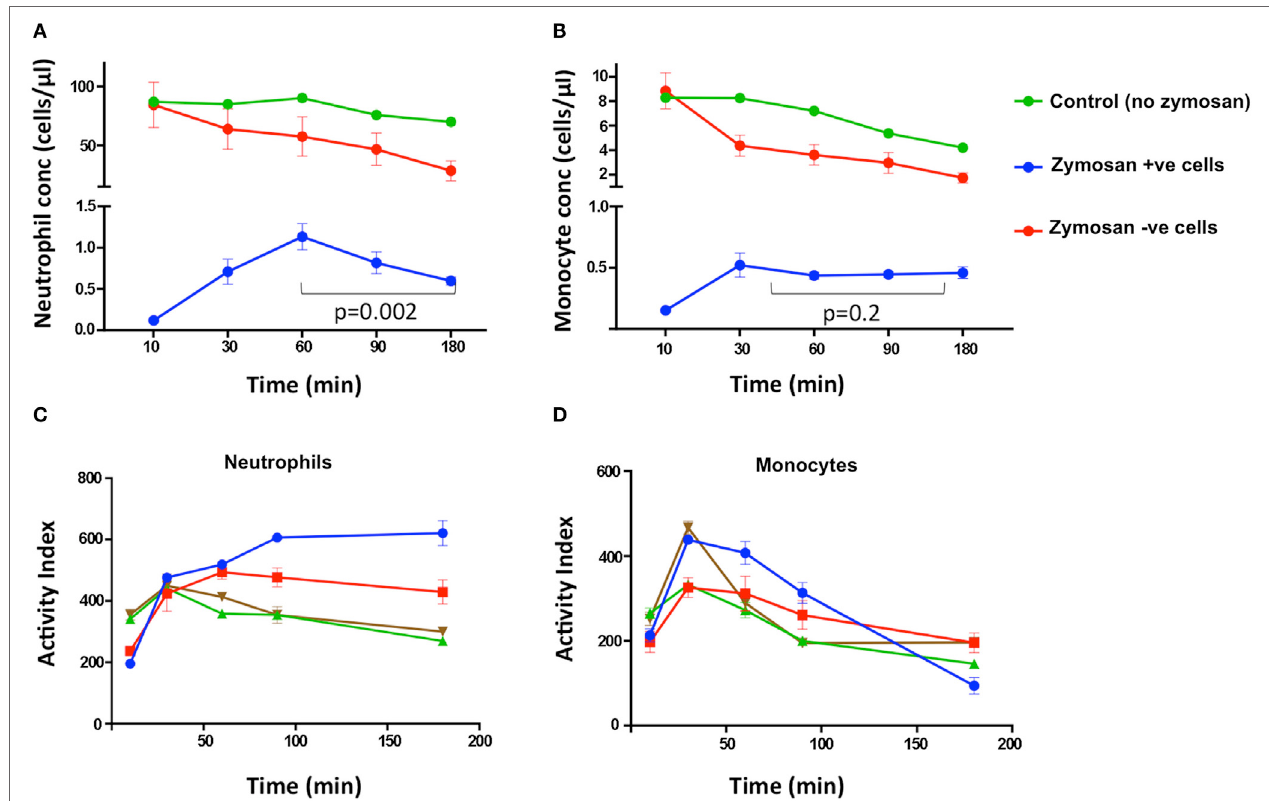
FIGURe 4 | Cell concentrations and activity index (AI) of superoxide burst over time. The concentration of neutrophils (A) and monocytes (B) at different time points from HIV-negative control samples without zymosan (green), and samples incubated with zymosan reporter beads that had internalized zymosan (blue) or did not internalize zymosan (red). In (C) neutrophils and (d) monocytes, each color represents the superoxide AI data from different individuals. The AIs are from four healthy, HIV-negative individuals, each performed in triplicate.